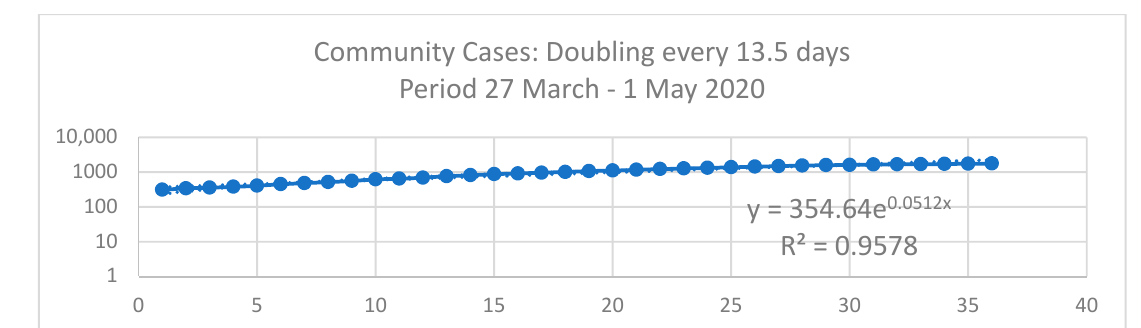
pore Ministry of Health and the WHO [68,69]. Last updated on 1 May 2020.